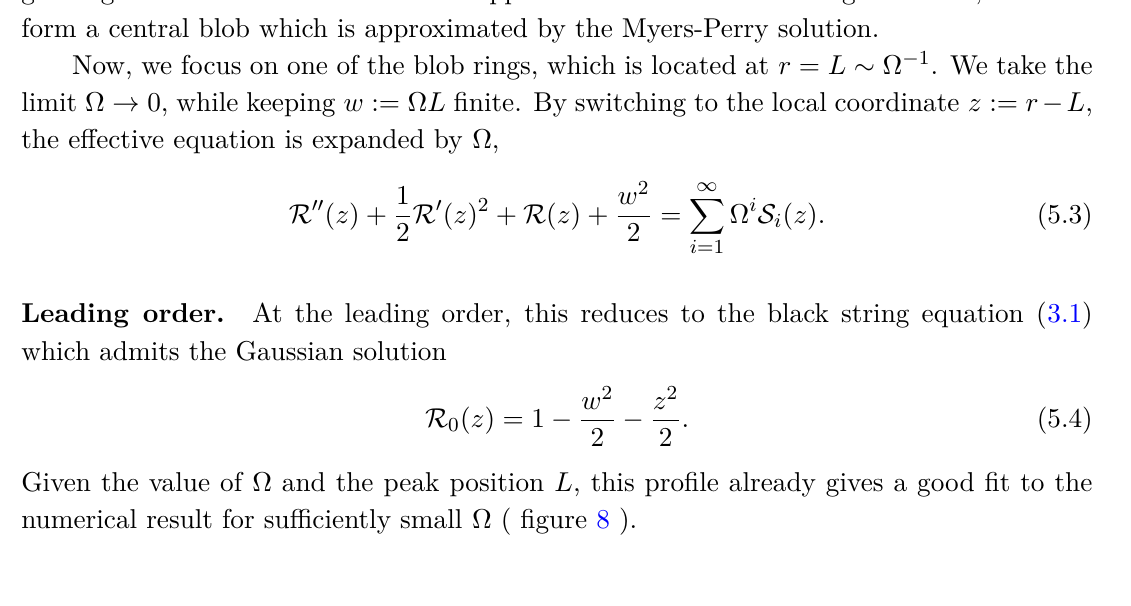
Ω 2 L 2 − 1 ( r − L i ) 2 with i 2 2